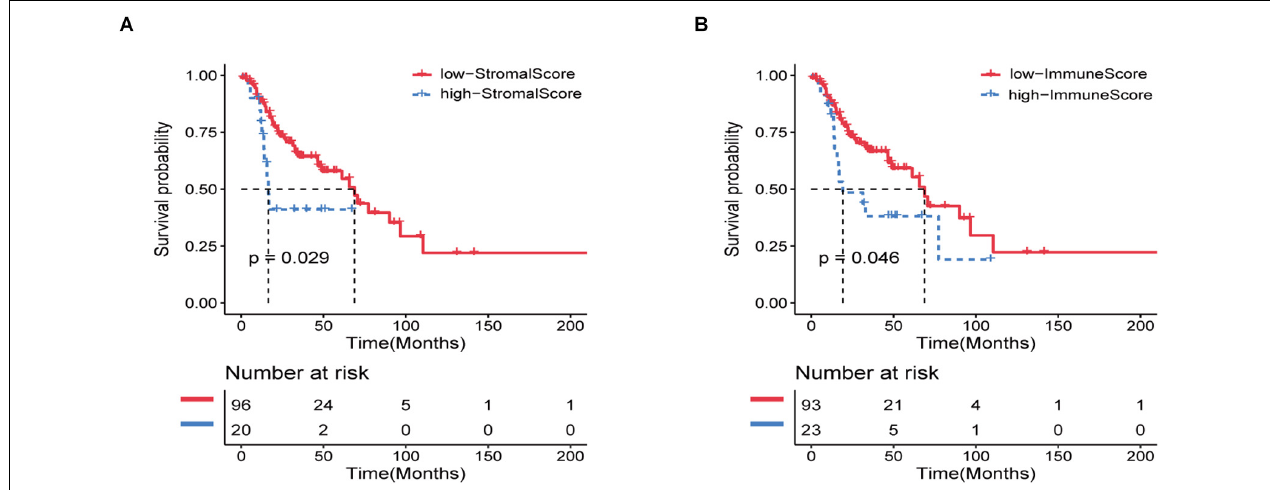
FIGURE 1 | Immune and stromal scores are significantly related to the prognosis of patients with recurrent HNSCC. Based on the immune/stromal scores, recurrent HNSCC patients were divided into high/low score groups. (A) Kaplan–Meier curve of the high and low immune score groups. (B) Kaplan–Meier curve of high and low stromal score